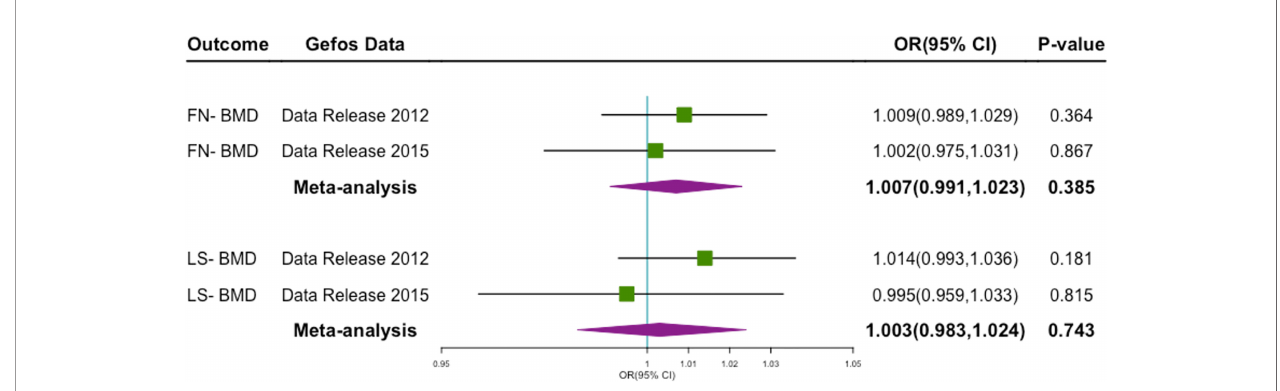
FIGURE 2 | Forest plot of MR study using genetic instruments with FN-BMD, LS-MD, OR, odds ratio; CI, con fi dence interval; FN-BMD, femoral neck Bone Mineral Density; LS-MD, lumbar spine Bone